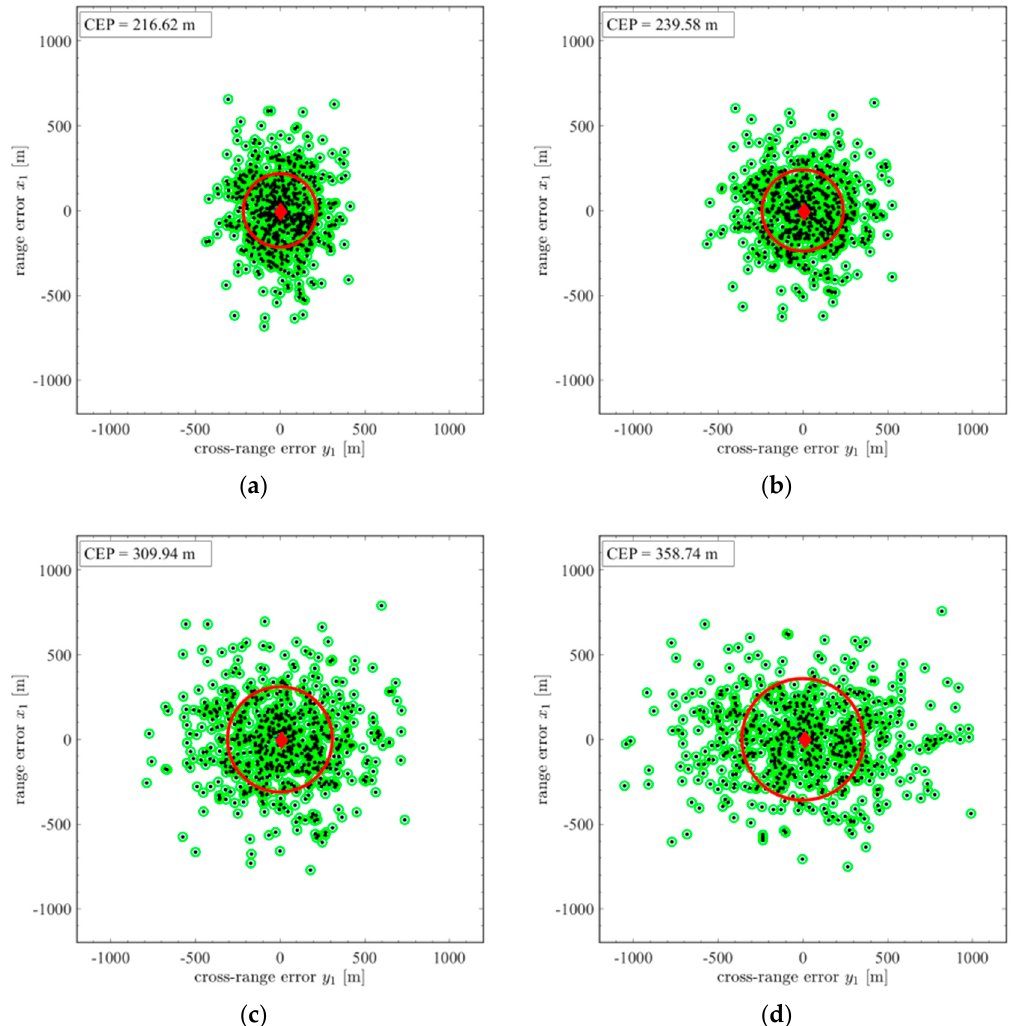
Figure 14. The hitting patterns for an uncontrolled projectile for various nominal launch angles (a) 𝛩 (cid:2868) = 20° (b) 𝛩 (cid:2868) = 30° (c) 𝛩 (cid:2868) = 40° (d) 𝛩 (cid:2868) = 50°.